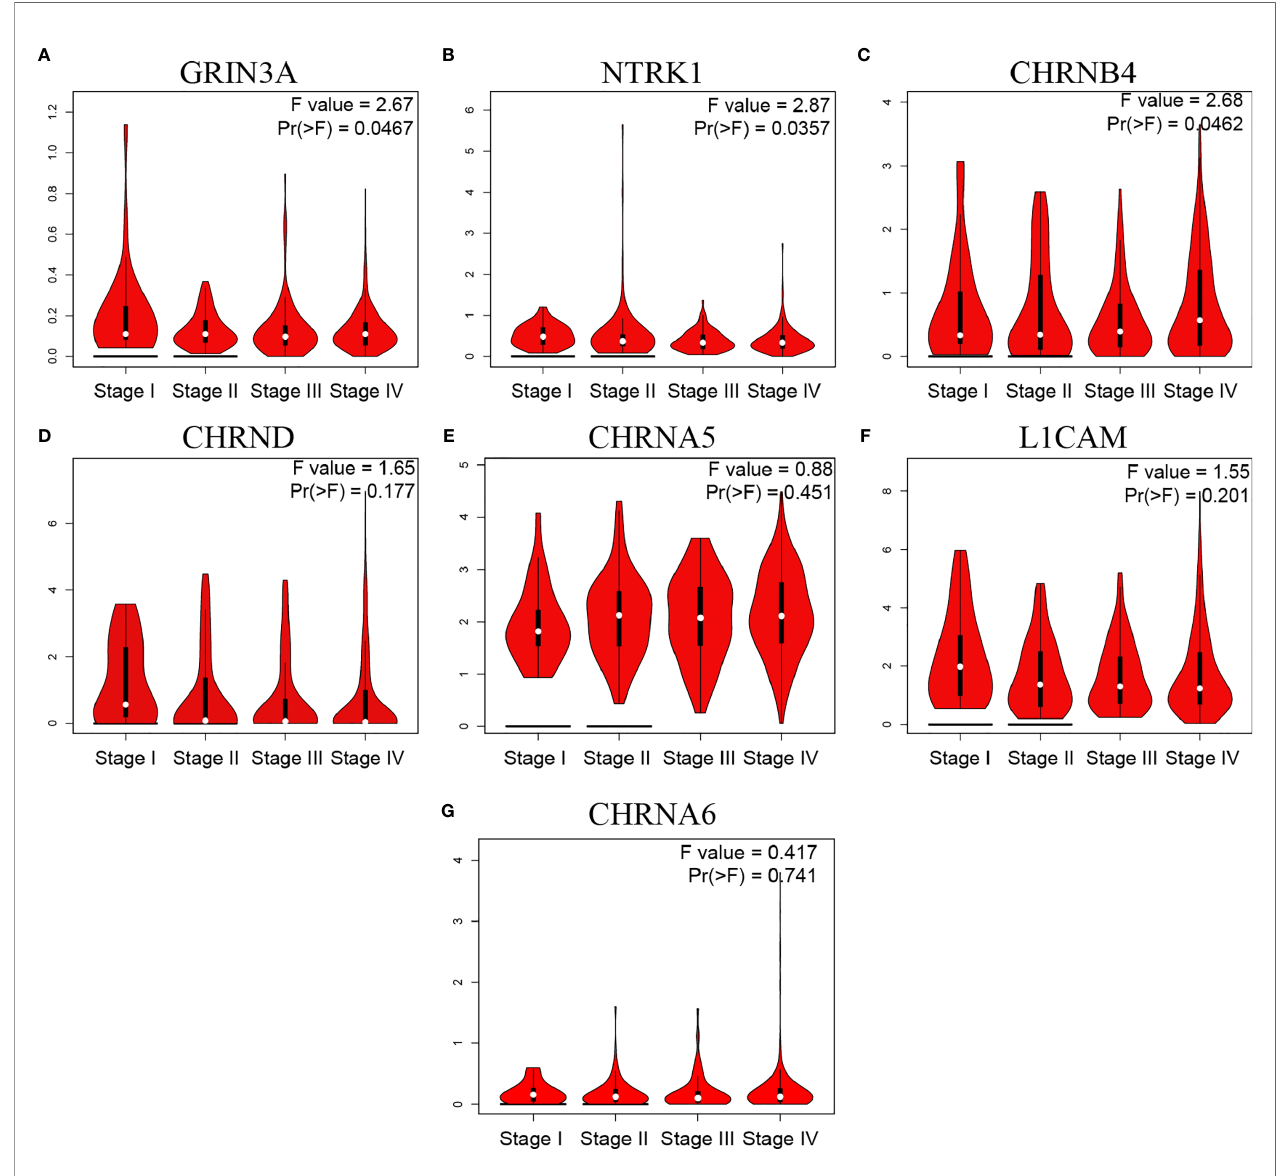
FIGURE 8 | The relationship between seven prognostic NCCGs and HNSC clinical stage. Expression of GRIN3A (A) , NTRK1 (B) , CHRNB4 (C) , CHRND (D) , CHRNA5 (E) , L1CAM (F) , and CHRNA6 (G) in different stages in HNSC. NCCGs, nerve-cancer cross-talk genes; HNSC, head and neck squamous cell